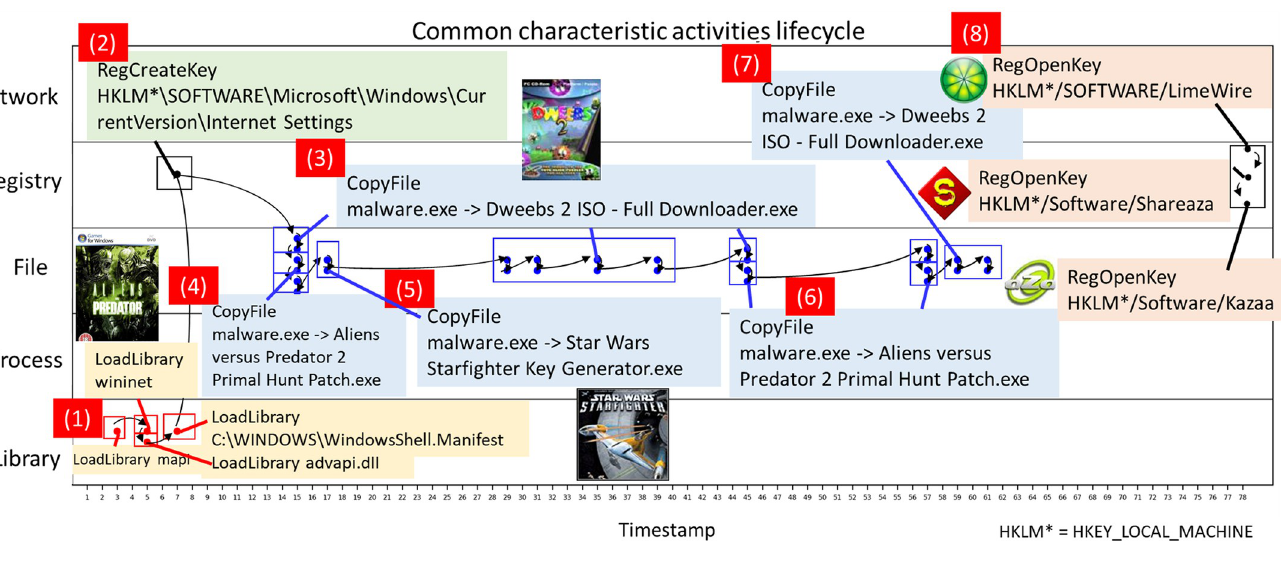
Fig 1. Sample life cycle of Eggnog